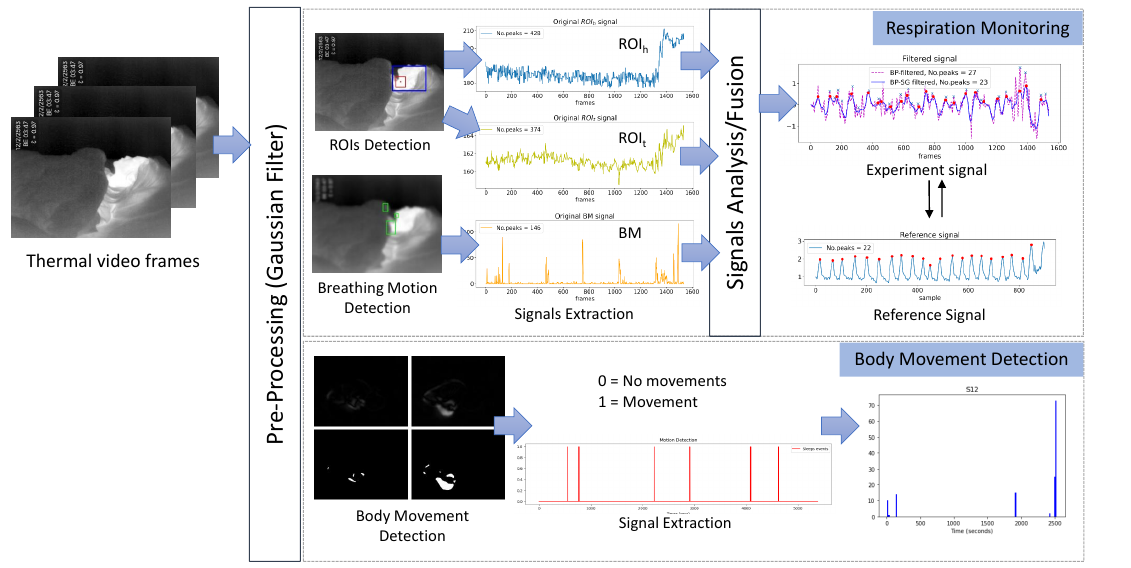
Figure 1. Proposed